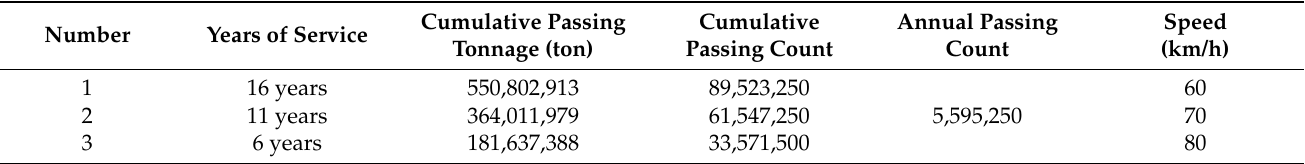
Table 1. Parameters for the finite element